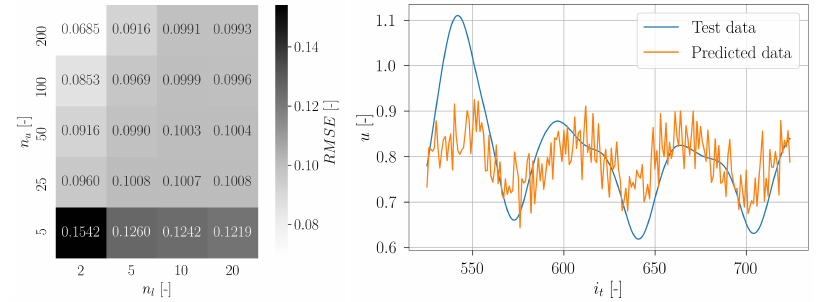
Figure 16. Heatmap and timeseries reconstruction for setup 3 of the cylinder case. As well as for setup 1 and setup 3, the optimum of the grid search for setup 4 was obtained for n l = 2 layers and n u = 200 units. The timeseries reconstruction is given for i t = 500 . . . 599 in Figure 17. It is clearly visible that the transient signal was not predicted correctly. Also here, just a periodic fluctuation of the predicted signal can be observed, superimposed by some